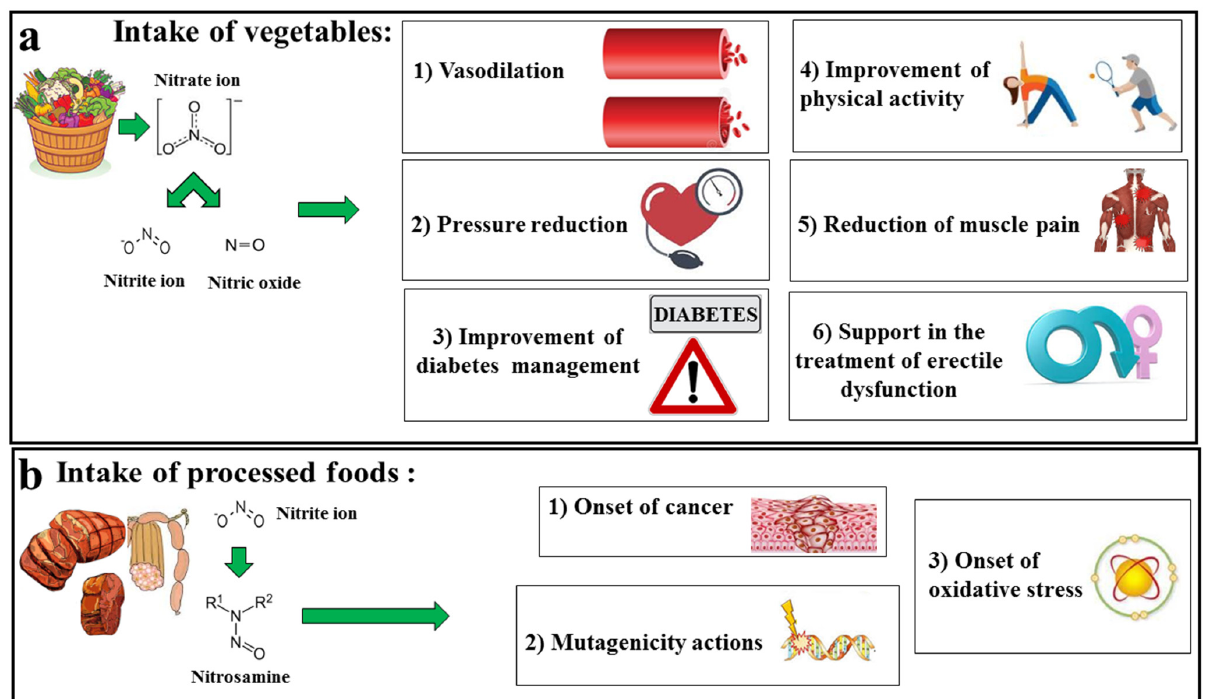
Figure 5. The protective and harmful roles of nitrogen compounds ingested through the diet. In diagram ( a ) the intake of plant products, which offer a large amount of nitrates, is shown. Subsequently, nitrates are transformed into nitrites and NO. The increased concentration of NO has beneficial effects on health, including vasodilation, reduction in blood pressure, better control of diabetes, better physical activities, reduction in muscle pain, and an improvement in the treatment of erectile dysfunction. In contrast, diagram ( b ) highlights the main effects from the intake of processed foods. The nitrites present in these foods can form toxic nitrosamines that are able to facilitate the onset of cancer, induce mutagenicity actions, alter biological macromolecules, and promote oxidative stress.